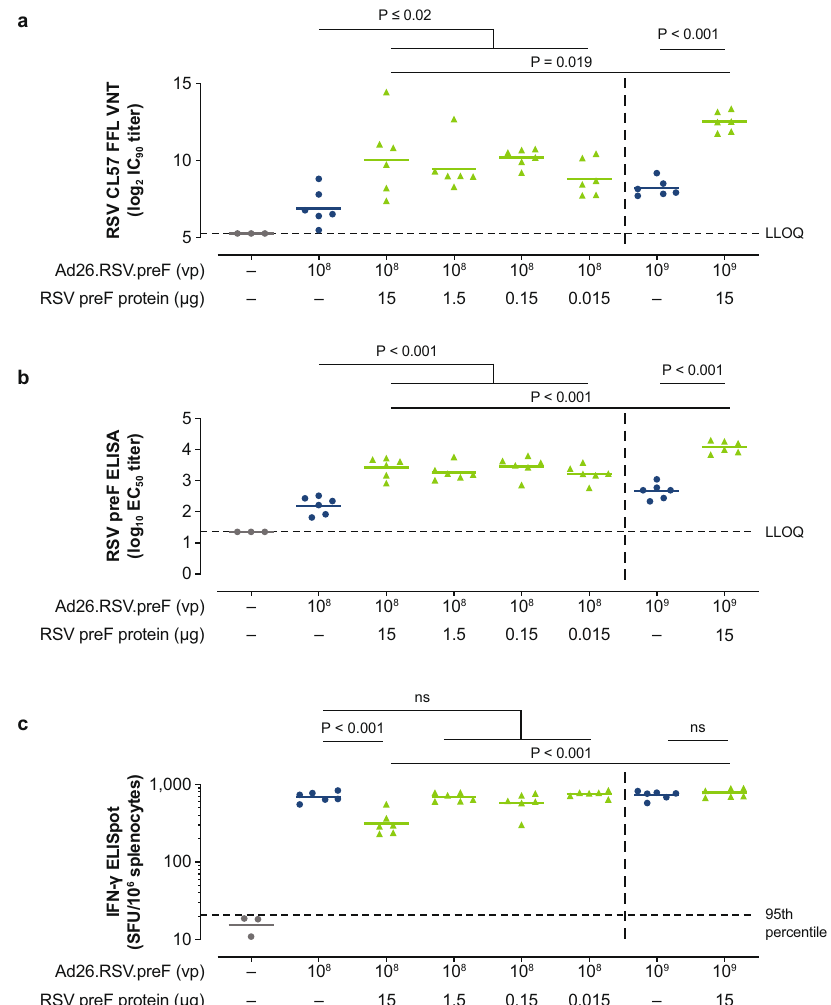
Fig. 1 Humoral and cellular immunogenicity in naïve mice. Naïve female BALB/c mice were immunized at Week 0 and Week 4 with Ad26.RSV.preF (1 × 10 8 or 1 × 10 9 vp), Ad26.RSV.preF (1 × 10 8 vp) combined with RSV preF protein (15, 1.5, 0.15 or 0.015 µg), or Ad26.RSV.preF (1 × 10 9 vp) combined with RSV preF protein (15 µg; n = 6 each group). VNT against RSV CL57, expressed as log 2 IC 90 titers, using an FFL virus neutralization assay ( a ) and RSV preF-binding antibody titers, expressed as log 10 EC 50 titers ( b ), were measured in serum at Week 6. Horizontal bars indicate mean titers per group, and dotted lines indicate the LLOQ or the LOD. Cellular responses were measured by IFN- γ ELISpot in splenocytes at Week 6 ( c ), and the responses are shown as SFU per million splenocytes. The horizontal lines indicate the geometric mean titer per group, and the dotted line indicates the 95 th percentile of the response of unstimulated cells. Statistical comparisons were made by ANOVA for potentially censored measurements (Tobit model) and were conducted at an overall signi fi cance level of α = 0.05. Ad26, adenovirus type 26; EC50, 50% effective concentration; ELISA, enzyme-linked immunosorbent assay; ELISpot, enzyme-linked immune absorbent spot; FFL, fi re fl y luciferase; IC90, 90% inhibitory concentration; IFN- γ , interferon- γ ; LLOQ, lower limit of quanti fi cation; LOD, limit of detection; ns, not signi fi cant; preF, prefusion conformation-stabilized RSV F protein; RSV, respiratory syncytial virus; SFU, spot-forming units; VNT, virus neutralization titers; vp, viral